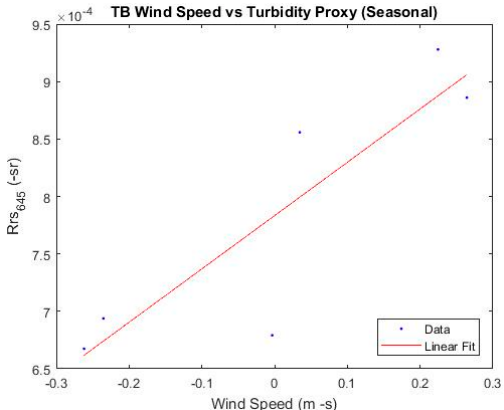
Figure 4. Plot of Tampa Bay seasonal XE 90 wind speed vs. turbidity proxy anomalies (R 2 adj = 0.707, p = 0.001, n = 6).